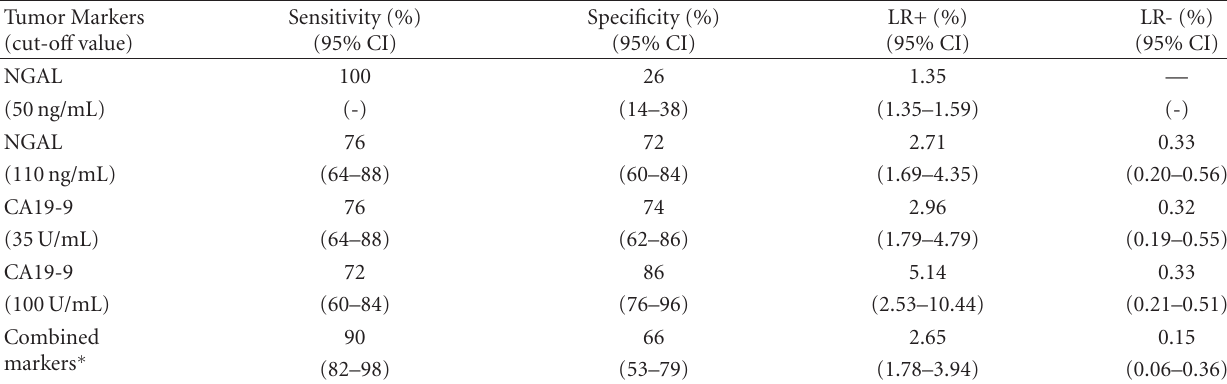
Table 3: Performance of the biomarkers for the diagnosis of cholangiocarcinoma.